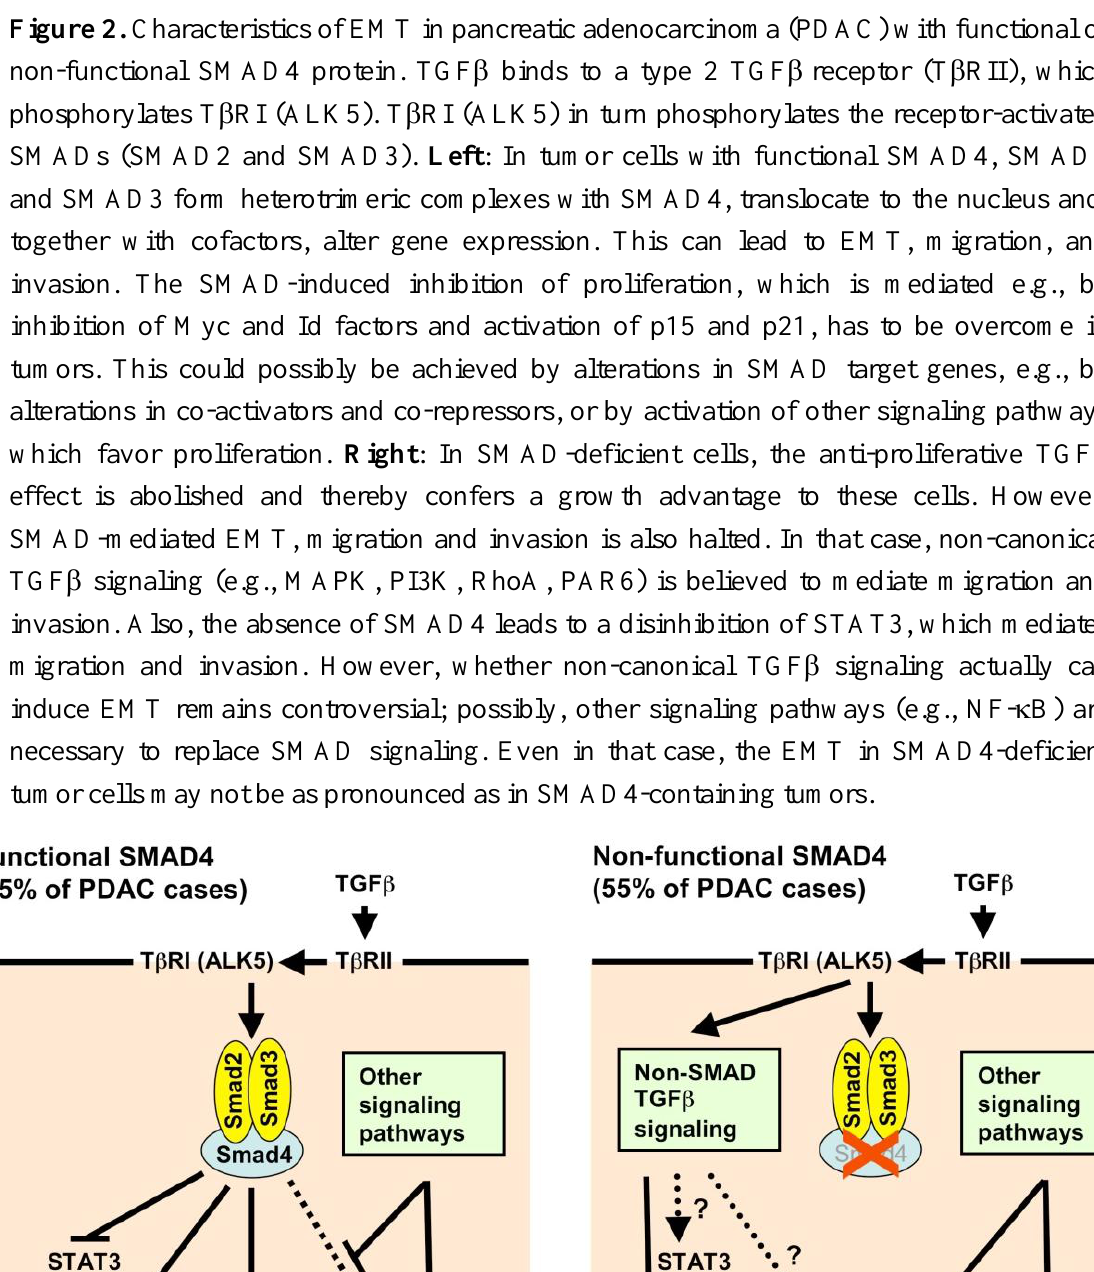
Figure 2. Characteristics of EMT in pancreatic adenocarcinoma (PDAC) with functional or non-functional SMAD4 protein. TGF  binds to a type 2 TGF  receptor (T  RII), which phosphorylates T  RI (ALK5). T  RI (ALK5) in turn phosphorylates the receptor-activated SMADs (SMAD2 and SMAD3). Left : In tumor cells with functional SMAD4,